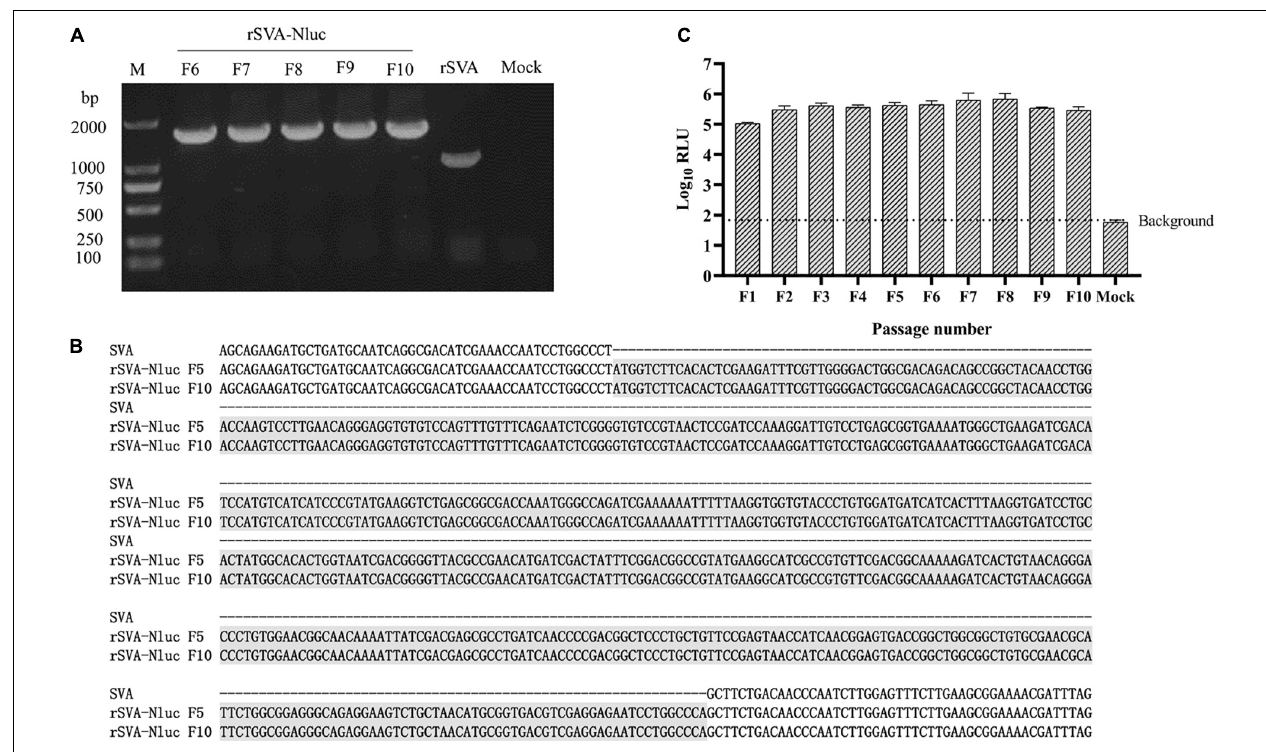
FIGURE 3 | Stability of the Nluc expressed by the rSVA-Nluc during serial passaging in BHK-21 cells. (A) RT-PCR analysis of the Nluc gene during virus passage. Viral RNA was extracted from culture supernatants of different passages in BHK-21 cells, and RT-PCR was performed with F1/R1 primer pair. (B) Sequence alignment analysis to assess the genetic stability of the F5 and F10 recombinant viruses. (C) The Nluc activity of rSVA-Nluc of F1-F10 passage. BHK-21 cells cultured were infected with rSVA-Nluc at an MOI of 0.5 and assayed for the Nluc activity in relative light units (RLU) at 48 h post-infection. Data represent mean values of three independent experiments with error bars representing the standard deviations of the